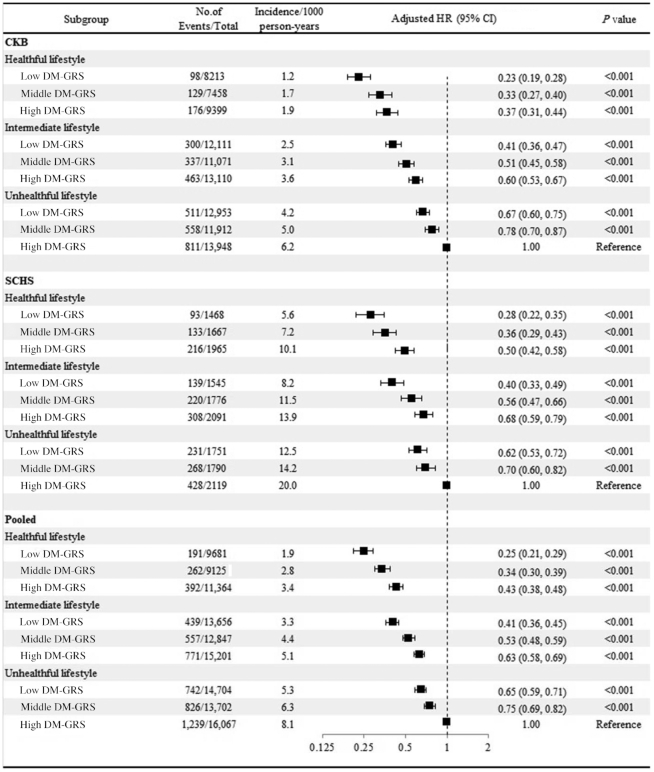
Adjusted HRs for type 2 diabetes events, according to DM-GRS and lifestyle score. In these comparisons, participants with a low DM-GRS and healthy lifestyle serve as the reference group. The participants in the 2 cohorts were pooled and the model was adjusted for sex, age, region, and data sources. There was no evidence of significant interactions between genetic and lifestyle risk factors (P-interaction = 0.60 in the pooled cohort, 0.38 in the CKB, 0.10 in the SCHS). Unadjusted incidence rates are reported per 1000 person-years of follow-up. CKB, China Kadoorie Biobank; DM-GRS, diabetes genetic risk score; SCHS, Singapore Chinese Health Study.